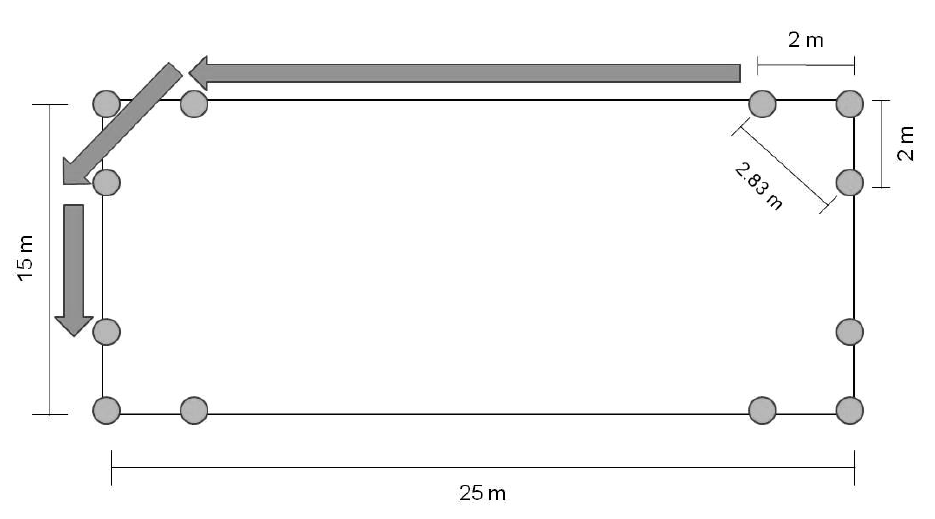
Figure 2. Test area for the 12-minute aerobic